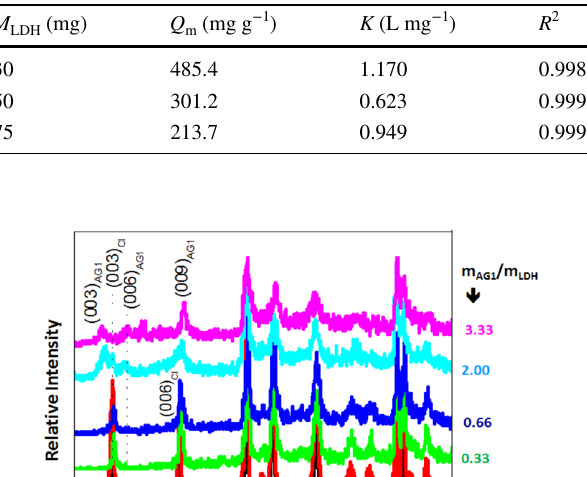
Fig. 7 Linearization curves with three different sorbing doses (30, 50 and 75 mg) Table 5 Langmuir parameters for AG1 retention by the [Zn–Al–Cl]-